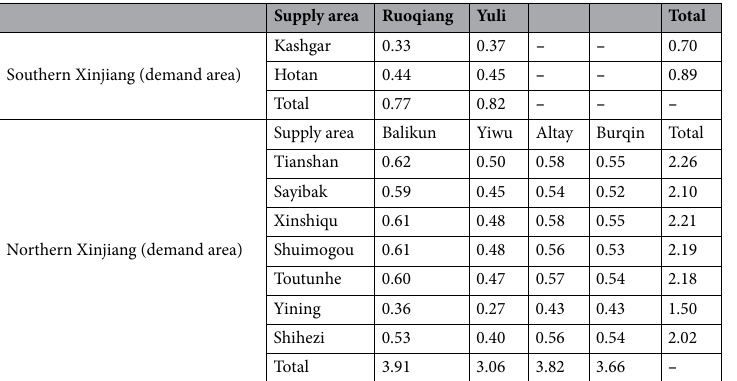
Table 6. CERF in Xinjiang carbon sequestration ecological supply and demand